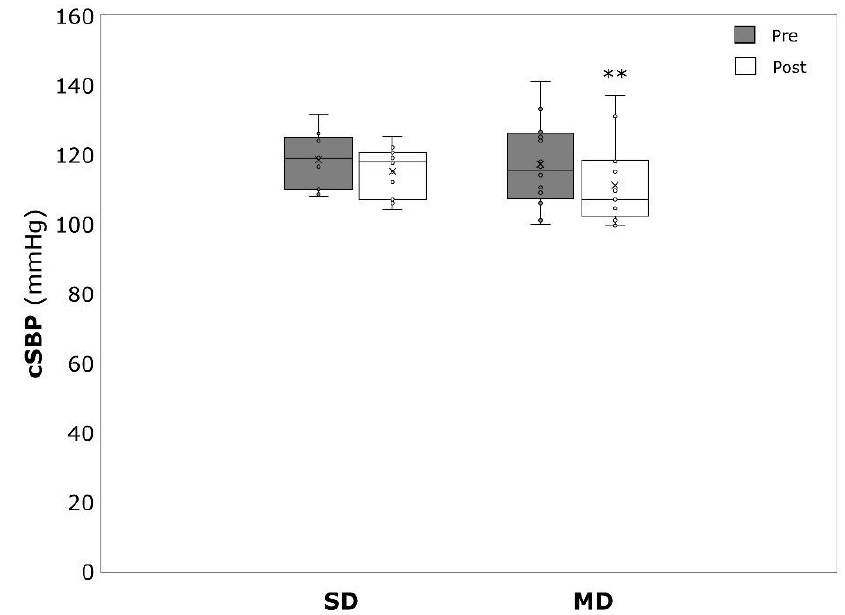
Figure 4. Central systolic blood pressure (pSBP) before (pre) and after (post) the intervention period for severely depressed (SD) and mildly depressed (MD). ** p < 0.01 within-group difference.